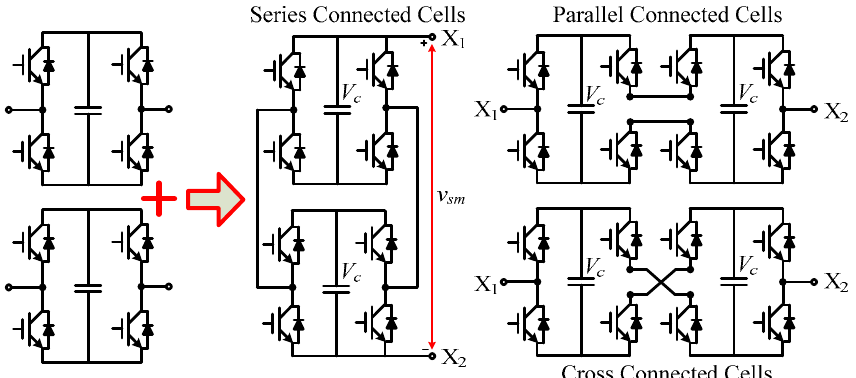
Figure 17. Derivation of multilevel sub ‐ modules with HBSM cells. ( a ) basic cells, ( b ) DHBSSM, ( c ) Asymmetrical double HBSM.